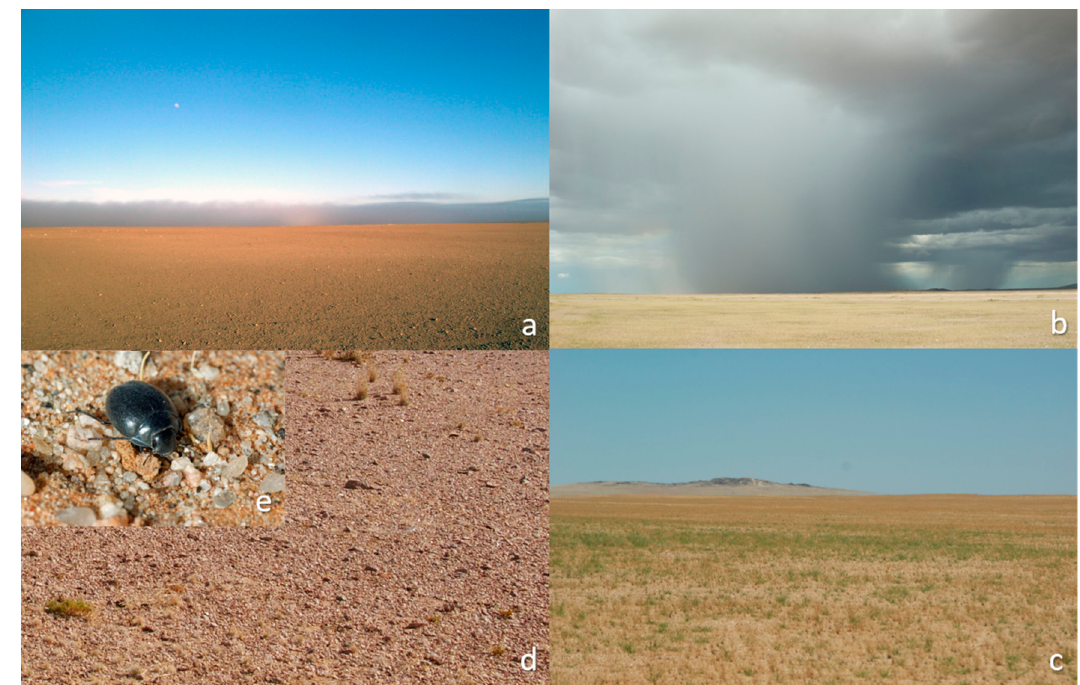
Figure 1. Clockwise from top left: ( a ) bare gravel plain with a distant fog cloud during an interpulse year, ( b ) effective rainfall driving the production of ephemeral grasses, ( c ) which dries, ( d ) becomes detritus, ( e ) and is consumed by tenebrionid beetles such as Zophosis moralesi